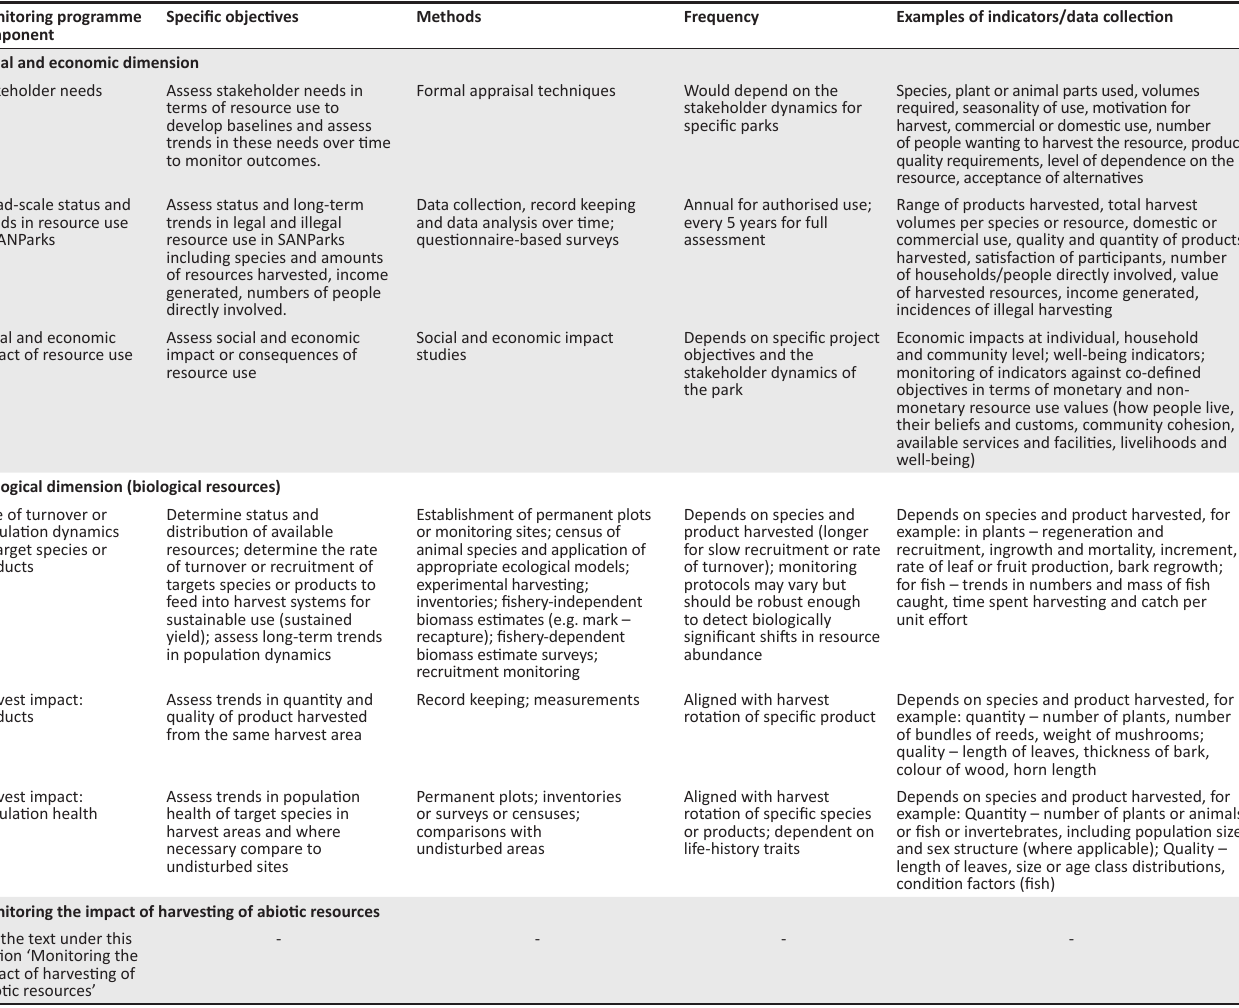
TABLE 1: Components of the South African National Parks resource use monitoring programme for the three dimensions of